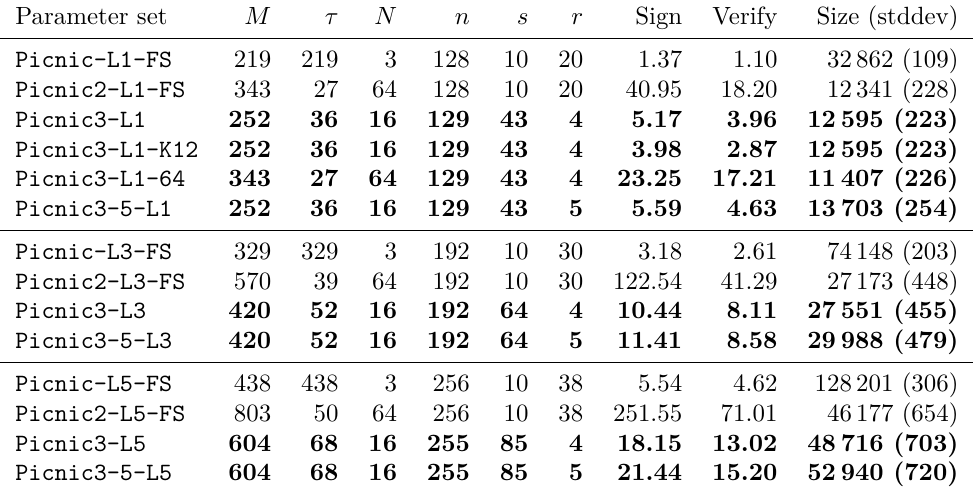
Table 6: Benchmarks of Picnic parameter sets, grouped by security level. Picnic-* and Picnic2-* refer to the existing parameter sets, while Picnic3-* are the new recommended sets and Picnic3-5-* is a variant of Picnic3 with one additional LowMC round (i.e., r = 5). The parameter set Picnic3-L1-K12 is Picnic3, but with the KangarooTwelve hash function. The parameter set Picnic3-L1-64 is Picnic3, but with parameters for 64 parties to show the tradeoff between signature size and speed. Sign and verify times are in milliseconds and signature sizes are in bytes. The average signature size of 1000 signatures is given along with the standard deviation. All software was compiled using architecture dependent optimizations (such as AVX2